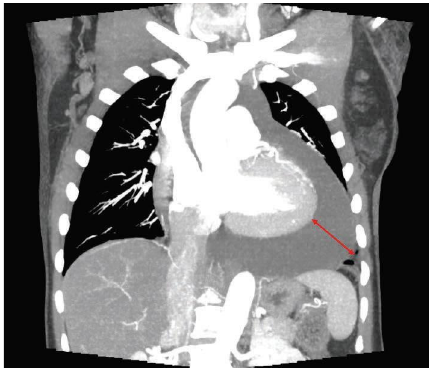
Figure 3: Coronal view of chest CTwith angiography obtained due to concern for aortic dissection shows large pericardial efusion (red line) without aortic dissection, pericardial or pleural thick- ening, or pericardial or pleural masses. Bilateral axillary lymph nodes with normal reniform morphology were present and were thought to be reactive in the setting of large pericardial efusion.